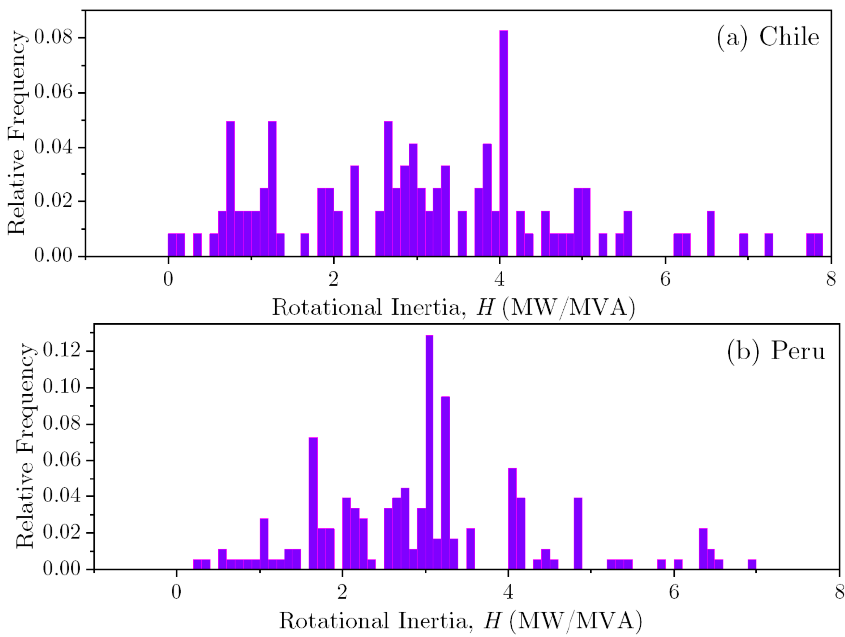
Figure 8. Relative frequency histogram of the individual rotational inertia of synchronous generators: ( a ) Chile, ( b ) Peru.